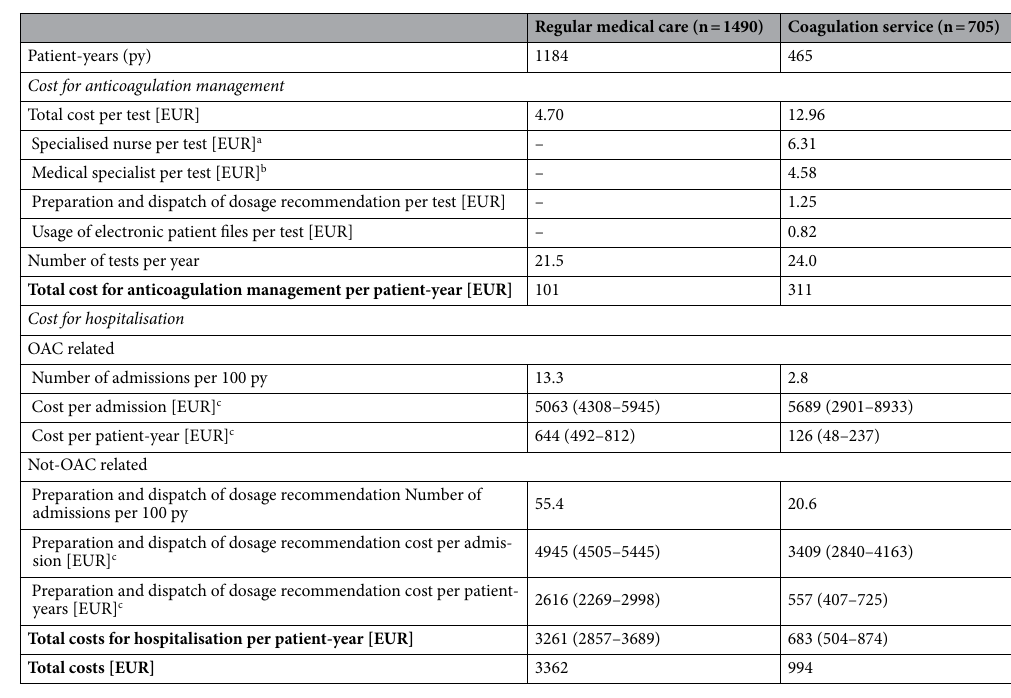
Table 3. Breakdown of hospitalisation and management costs stratified by treatment group. a Nursing time per test was assumed to be 12 min for the hourly wage of 31.55 EUR. b Medical specialists time per consult was assumed to be 5 min for the hourly wage of 54.92 EUR. c Confidence Intervals were generated via bootstrapping.